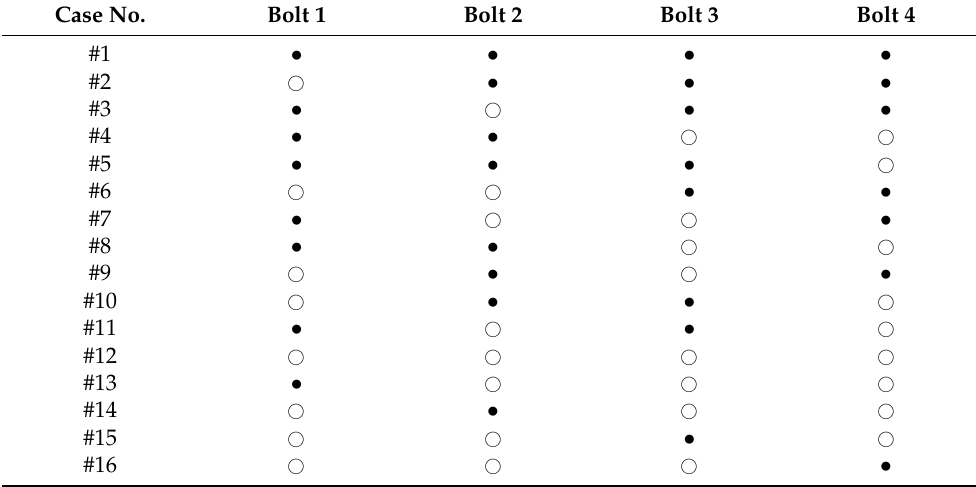
Table 2. Established necessary cases for bolt-loosening detection and identification. Case No.